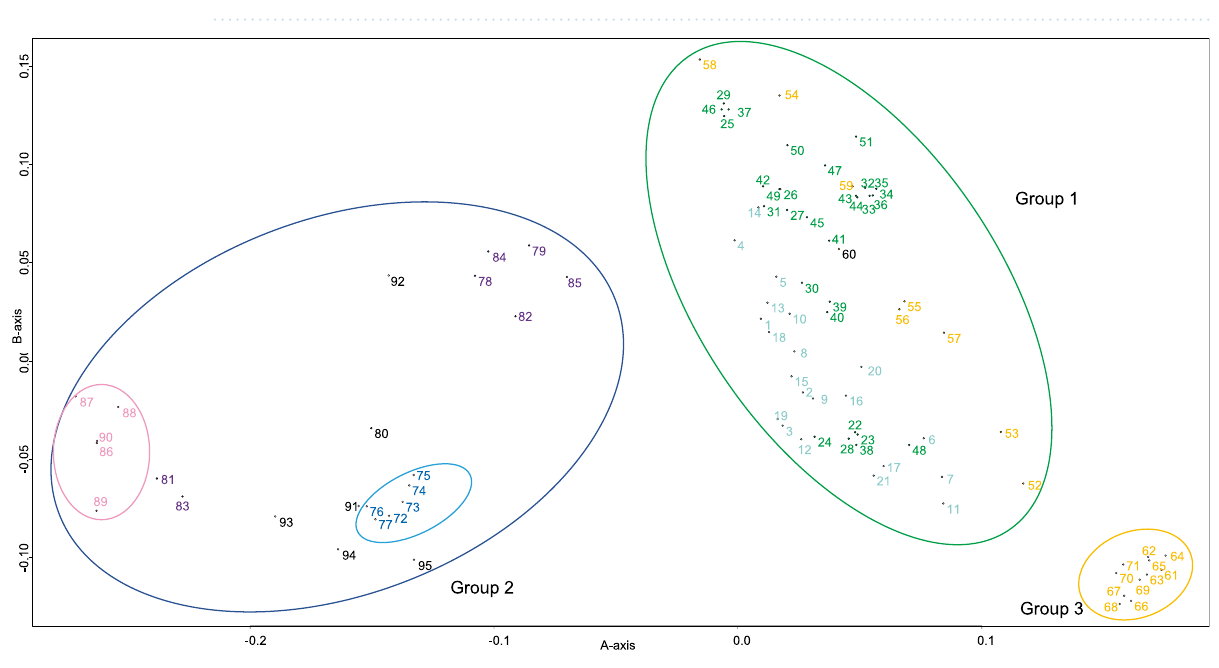
Figure 2. Principal component analysis (PCA) of Eriobotrya japonica accessions in the first two components based on 1822 SNP markers. The color of the sample number indicates the country or region where the sample was collected. Cyan represents germplasm resources and cultivars from China, darkgreen represents cultivars from Japan, orange represents germplasm resources from Japan, dark blue represents germplasm resources from Vietnam, purple represents cultivars from Israel, pink represents germplasm resources from Greece, black represents germplasm resources and cultivars from North America. Figure was generated using R software (version 4.1.1).